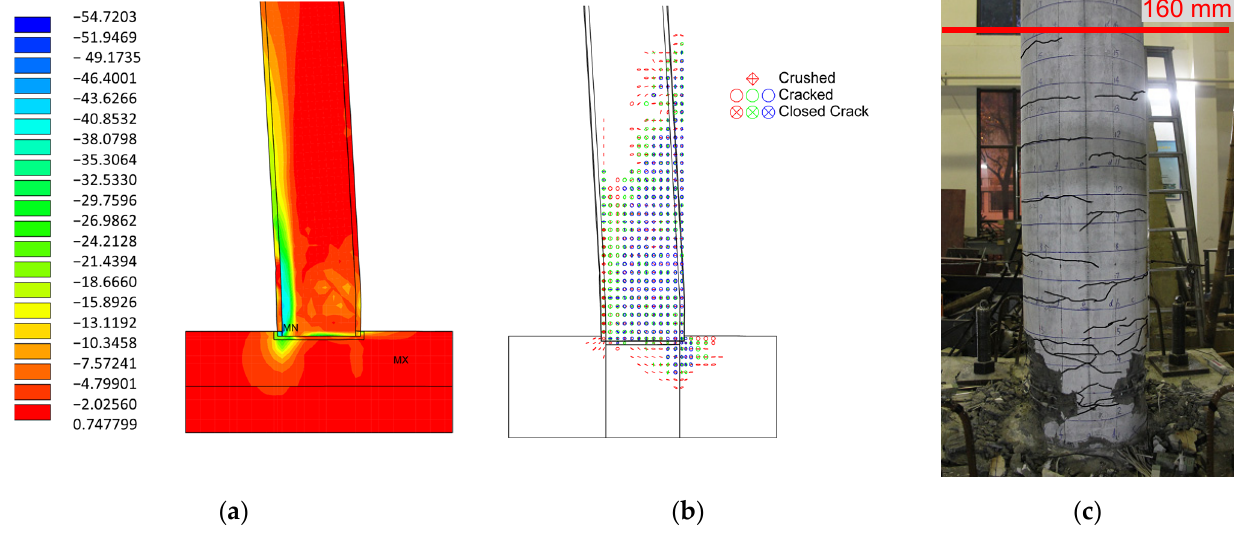
Figure 6. PMR’s simulation diagram, at the final stage: ( a ) PMR’s principal compressive stress (unit: MPa); ( b ) PMR’s crack and crushing; ( c ) Post-test damage of #1 for comparison (cracks are intentionally marked).